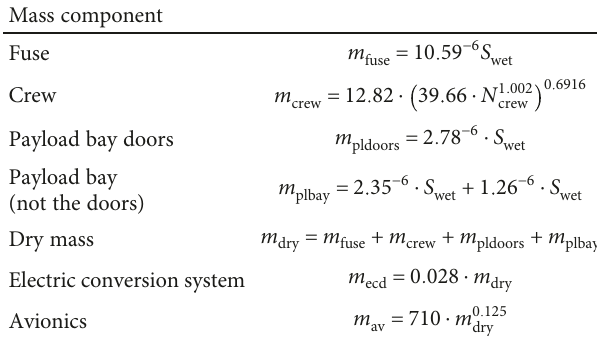
Table 4: Mass decoupling procedure.